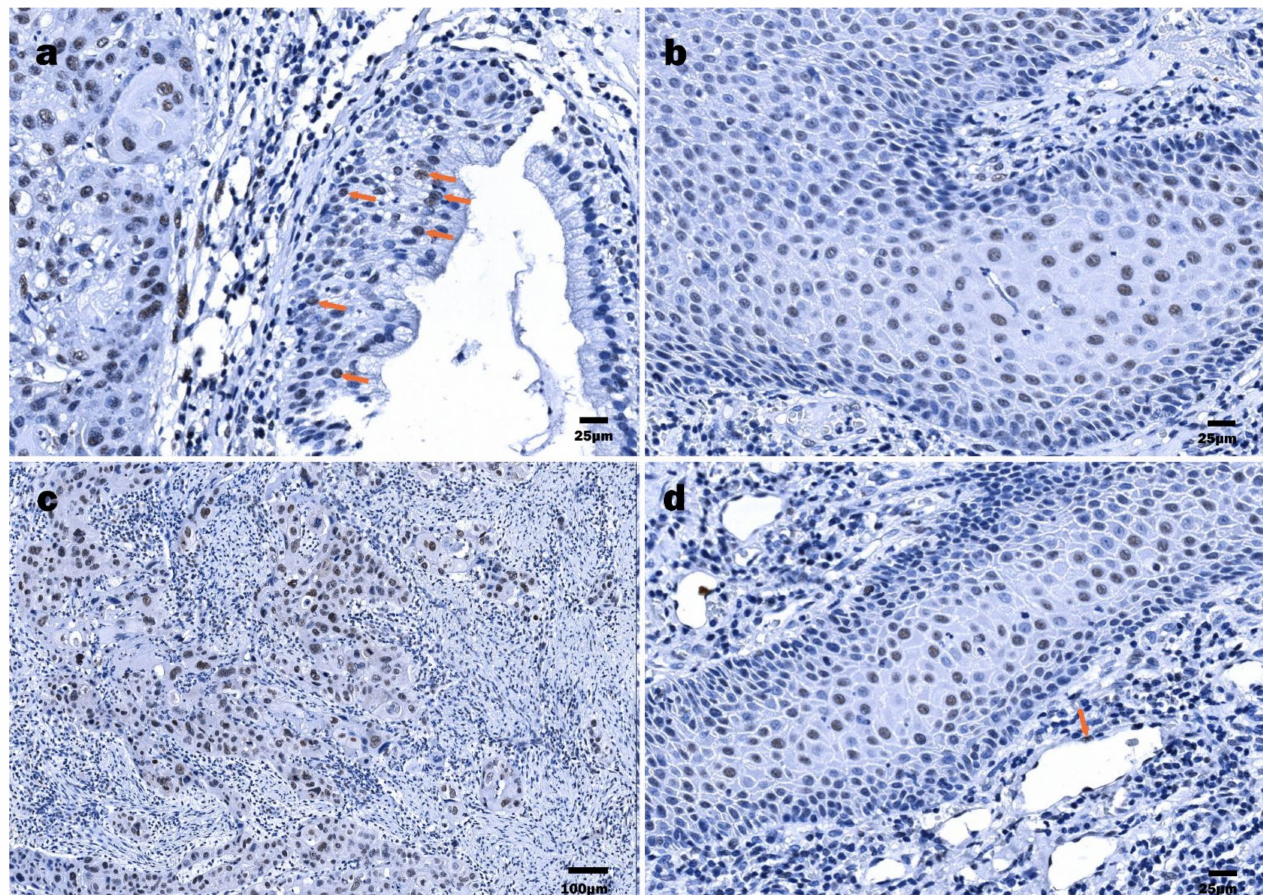
Figure 4. Immunohistochemical detection of HPV16 E7 oncoprotein: ( a ) LSCC, tumor cells within a nest and some surface cells (orange arrows) demonstrating nuclear HPV16 E7 positivity; ( b ) LSCC, numerous HPV16 E7-positive cells displaying nuclear immunostaining pattern; ( c ) LSCC, highly polymorphous HPV16 E7-positive tumor cells demonstrating nearly total nuclear decoration; ( d ) HPSCC, numerous HPV16 E7-positive cells displaying nuclear immunostaining pattern, endothelial (orange arrow)